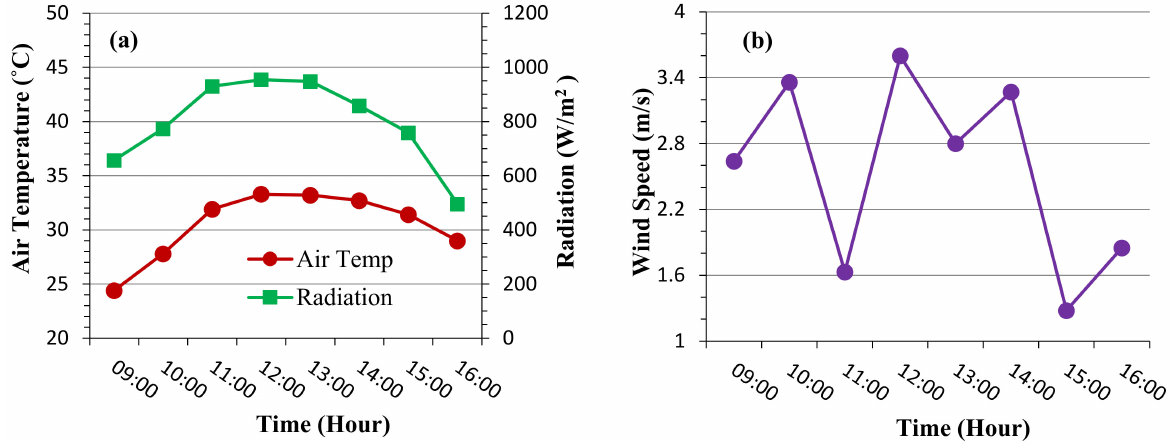
Figure 3. Variations of ( a ) solar radiation, ambient temperature, and ( b ) wind speed in the month of March in